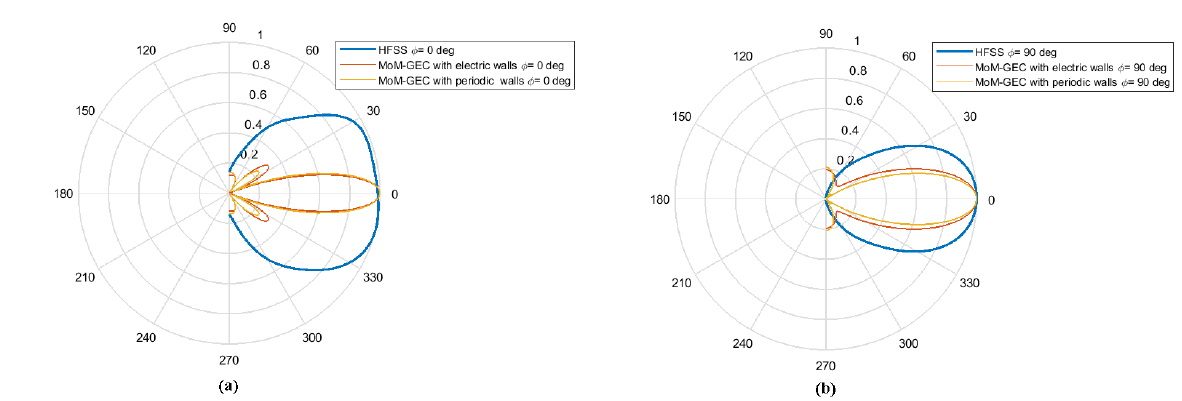
Figure 25. Normalized polar radiation patterns proven with the MoM-GEC method (with electric and periodic walls) compared to the HFSS software for a coupled periodic antenna array with 5 = 27 mm (period): ( a ) φ = 0 deg, ( b ) φ = 90 element and d x ≈ λ 0 2